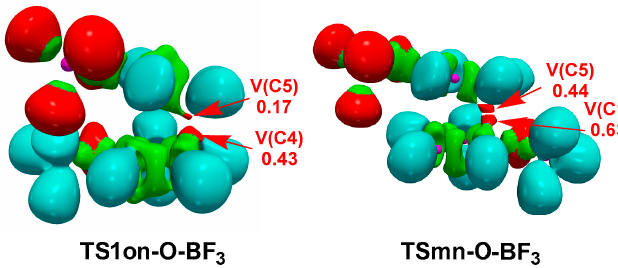
Figure 8. B3LYP/6-311G(d,p) ELF localization domains, represented at an isosurface value of ELF = 0.65, of the regioisomeric TS1on-O-BF 3 and TSmn-O-BF 3 involved in the P-DA reaction between Cp 13 and complex 7-BF . The electron populations, in average number of electrons, is given in e.